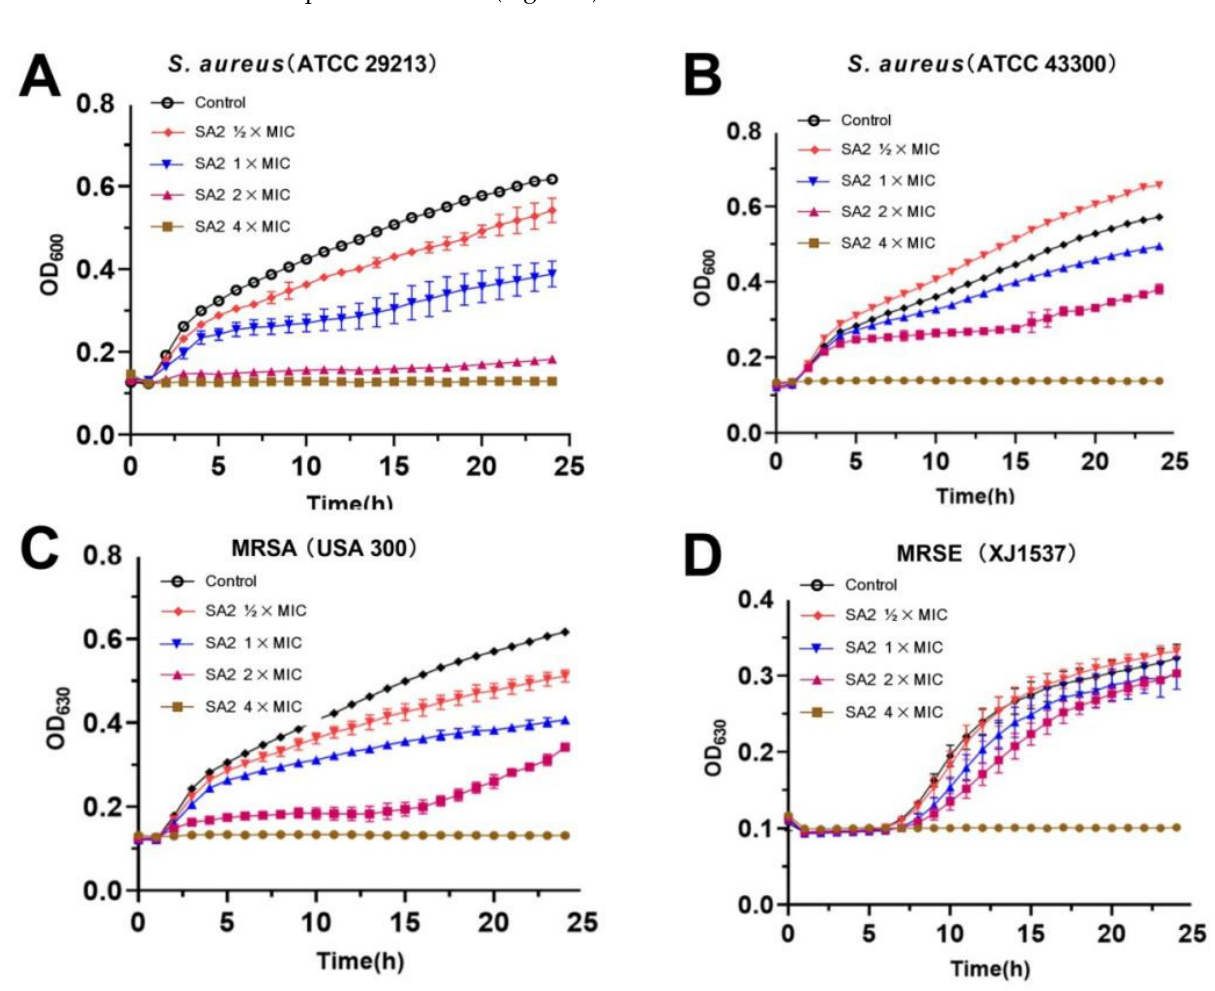
Figure 1. In vitro growth inhibition of SA2 to S. aureus and S. epidermidis . SA2 inhibited the growth curve of drug-susceptible S. aureus ATCC 29213 ( A ), S. aureus ATCC 43300 ( B ), MRSA USA300 ( C ), and methicillin-resistant S. epidermidis (MRSE) XJ1537 clinical isolated strain ( D ).